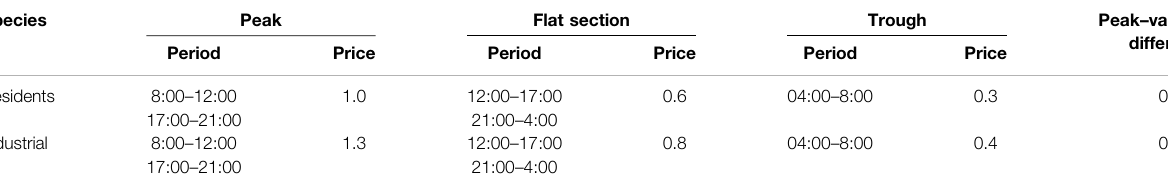
TABLE 2 | Time-of-use (TOU) power price.